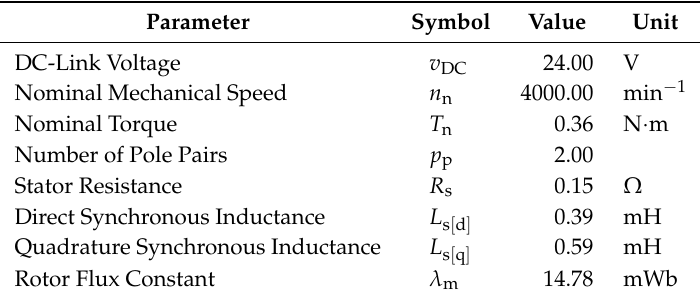
Table 1. Parameters of the PMSM used in the